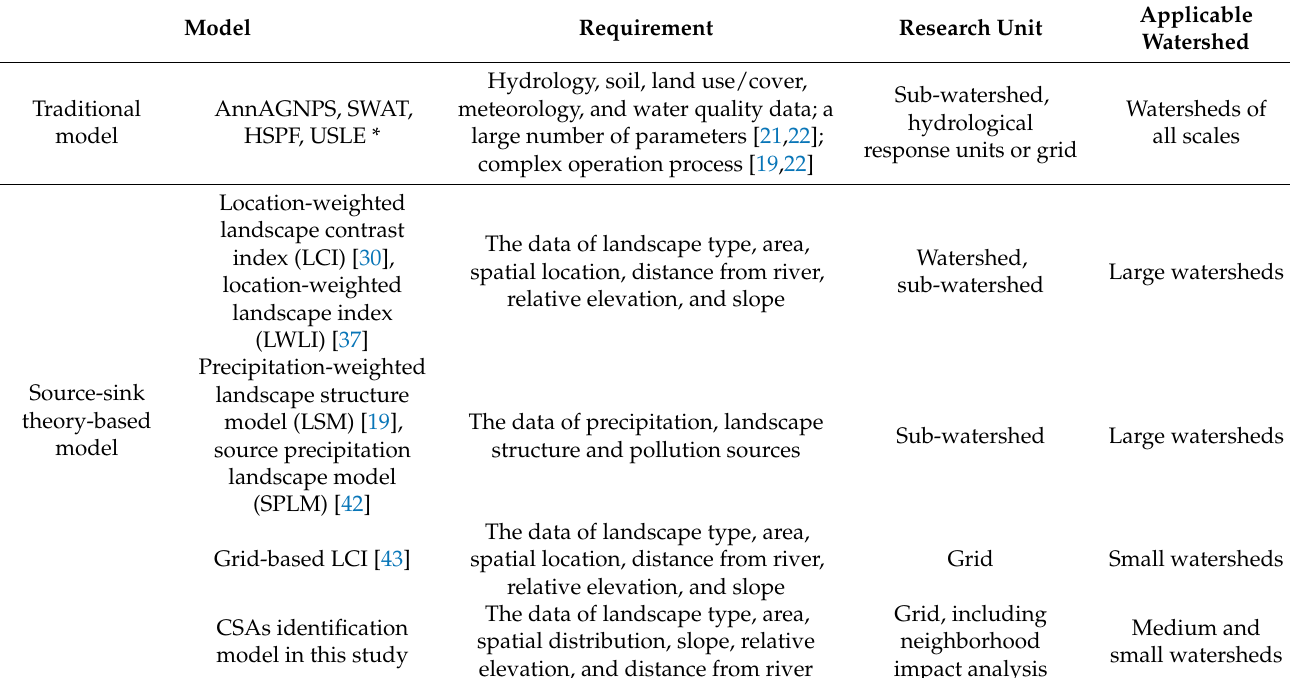
Table 7. A comparison of the proposed CSAs identification model with those used or proposed in previous studies. Model Requirement Research Unit